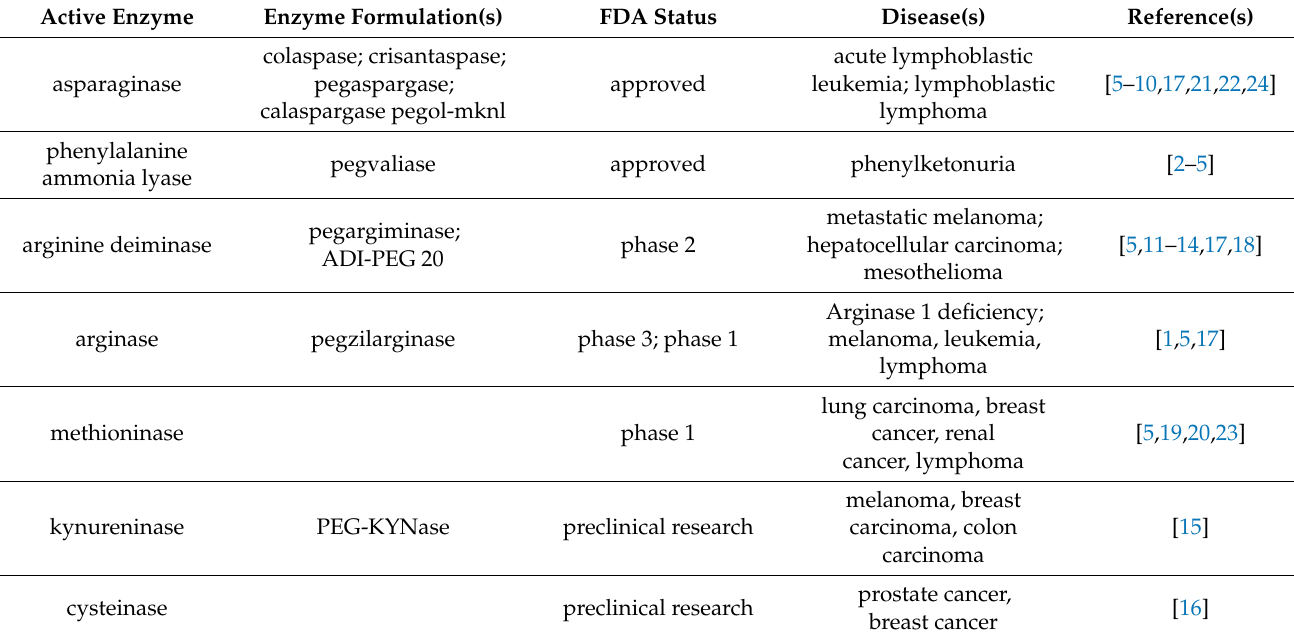
Table 1. Active enzymes used to treat